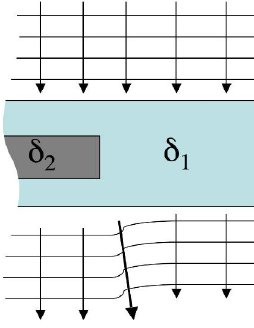
Figure 4. Interpretation of wavefront distortions in terms of changes in the x-ray